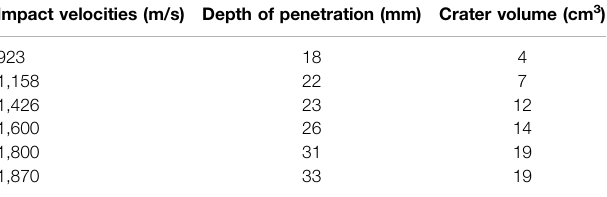
TABLE 2 | Depth of penetration and crater volume of the G50 steel targets at different impact velocities.